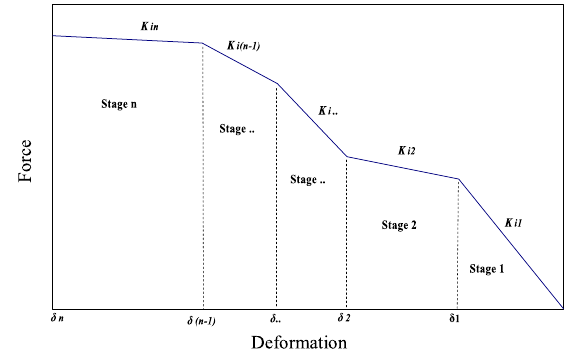
Figure 7. General piecewise force-deformation